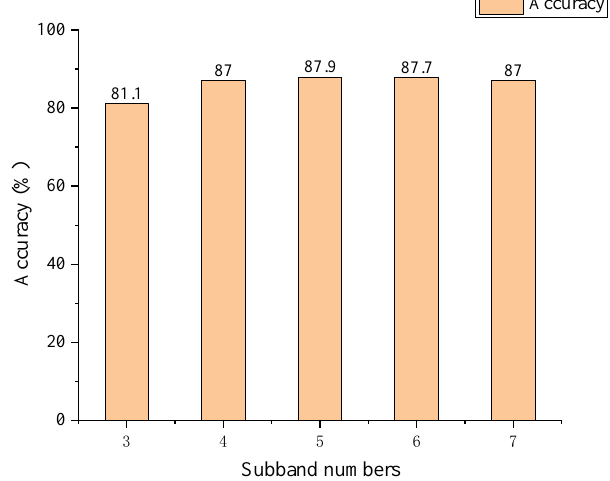
Figure 6. Accuracy of different subband